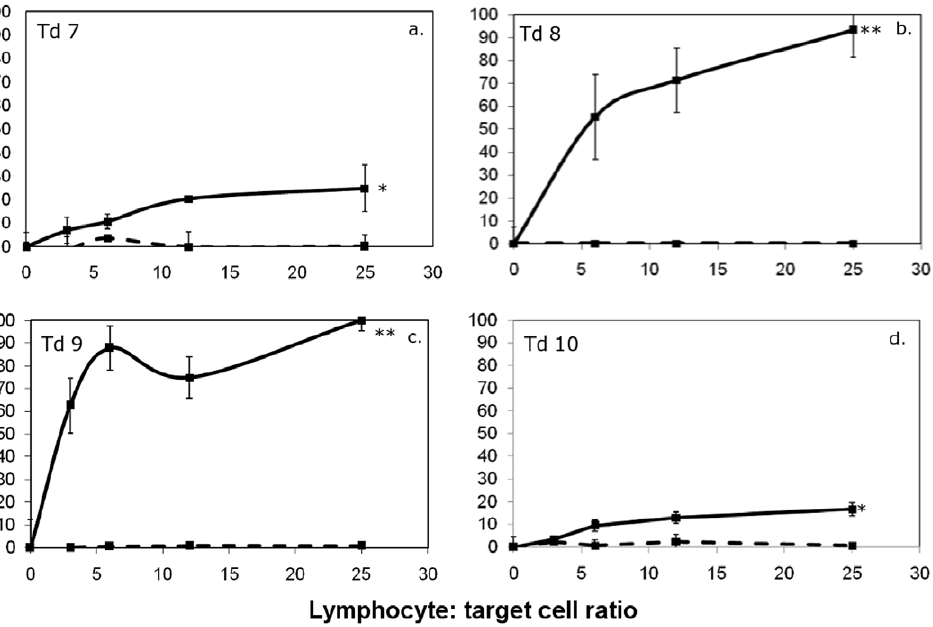
Figure 4. ADCC responses of MNC from naive Tasmanian devils against K562 cells. 51 Cr release assays were performed for 18 hr at lymphocyte: target ratios of 25:1, 12:1, 6:1 and 3:1, in the presence or absence of immune serum. Solid black lines represent the responses of MNC in the presence of K562 immune serum. Dashed lines represent levels of cytotoxicity in naive MNC without serum. Addition of immune serum significantly increased cytotoxicity levels in all devils (F test; * p , 0.05, ** p , 0.0005).